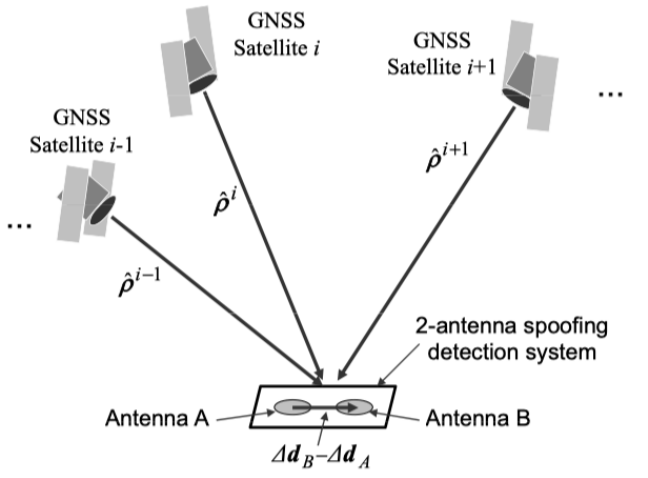
Figure 9. Schematic diagram of interferometry